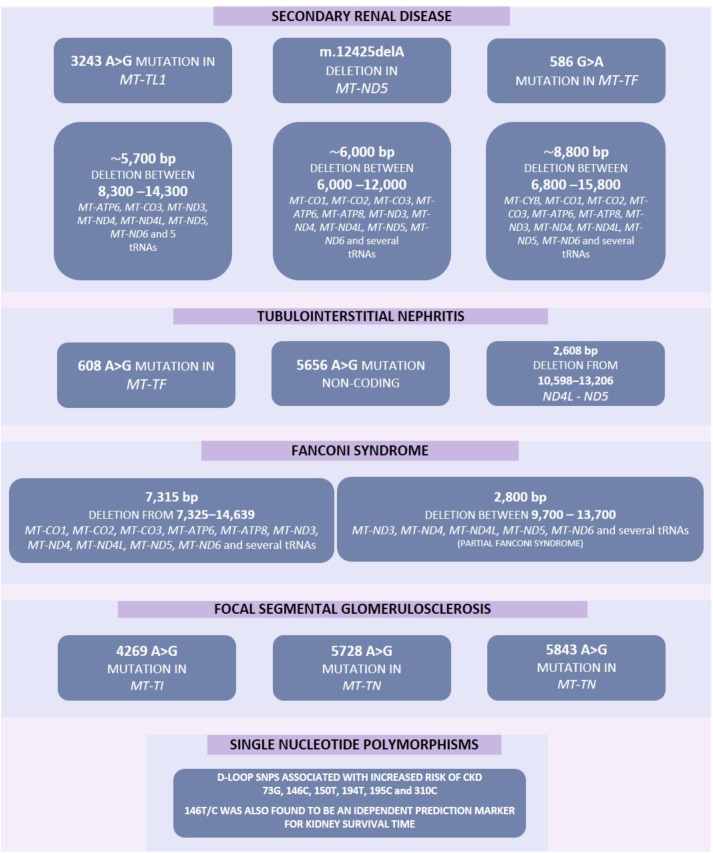
Increased mutation rate in mtDNA have previously been associated with several diseases including various forms of kidney disease. These mutations include point mutations, deletions and single nucleotide polymorphisms. Some of these mutations may result in several pathological phenotypes and these have been highlighted by a solid line between such genes.